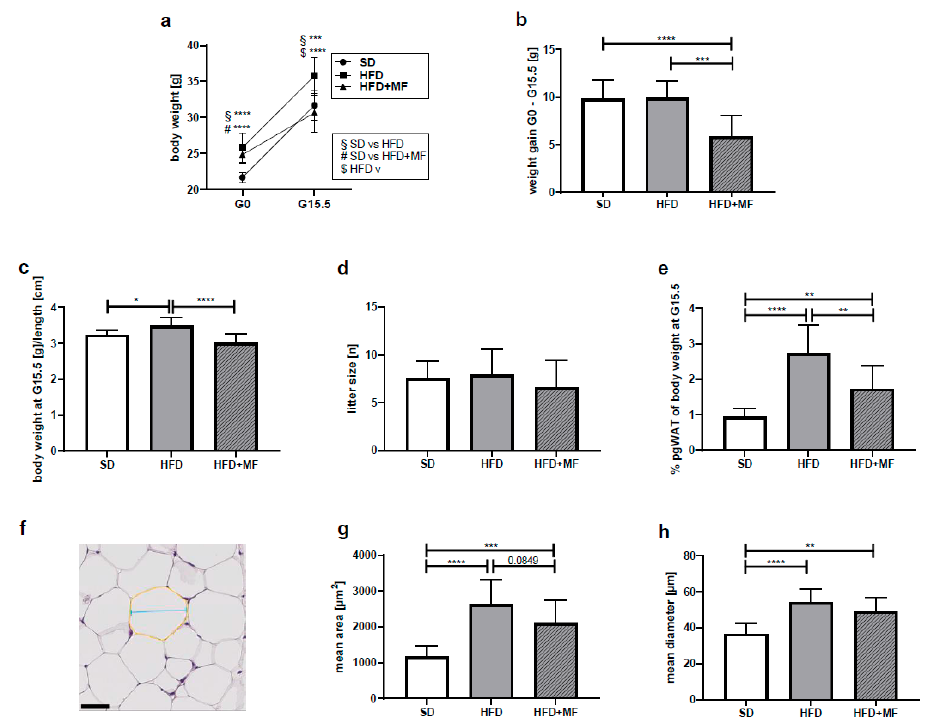
Figure 1. Metformin treatment reduced gestational weight gain, pgWAT mass and fat cell size in obese dams ( a ) Body weight at G0 (SD n = 13, HFD n = 11, HFD+MF = 11) and body weight at G15.5(SD n = 14, HFD n = 11, HFD + MF n = 11) in grams. ( b ) Weight gain during the gestation period from G0 until G15.5 in grams. SD n = 13, HFD n = 11, HFD + MF n = 11. ( c ) Body weight at G15.5, related to dams’ body length in grams/cm. SD n = 12, HFD n = 11, HFD + MF n = 8. ( d ) Litter sizes at G15.5. SD n = 14, HFD n = 11, HFD + MF n = 11. ( e ) PgWAT weight at G15.5, normalised to body weight in %. SD n = 13, HFD n = 8, HFD + MF n = 11. ( f ) Exemplary section from pgWAT of HFD group as used for fat cell size analysis with exemplified area (yellow) and diameter (blue). Scale bar equals 50 µm. ( g ) Mean area of pgWAT fat cells at G15.5 in µm 2 . SD n = 14, HFD n = 11, HFD + MF n = 11. ( h ) Mean diameter of pgWAT fat cells at G15.5 in µm. SD n = 14, HFD n = 11, HFD + MF n = 11. Due to missing data points (body weight at G0, body weight or pgWAT weight at G15.5, body length at G15.5), n -counts of mice included in analyses shown under a-i sometimes differ. SD: standard diet; HFD: high-fat diet; HFD + MF: high-fat diet plus metformin treatment; G: gestational day; pgWAT: perigonadal white adipose tissue; * p -value < 0.05; ** p -value < 0.01; *** p -value < 0.001; **** p -value < 0.0001.